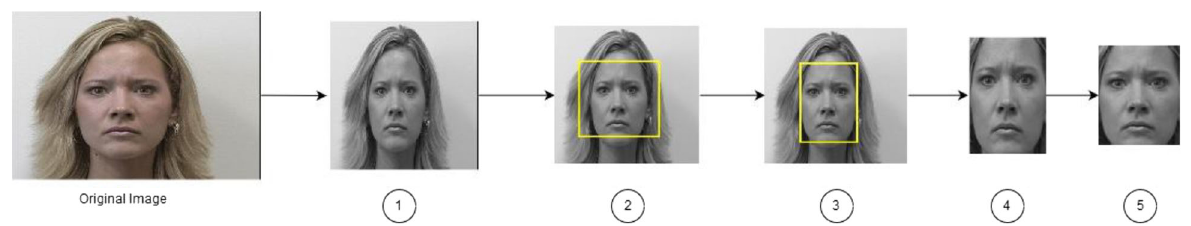
Fig. 4 Image preprocessing: (1) Gray scaling and resizing, (2) Viola – Jones, (3) border adjustment, (4) cropping, and (5) additional resizing (cid:129)